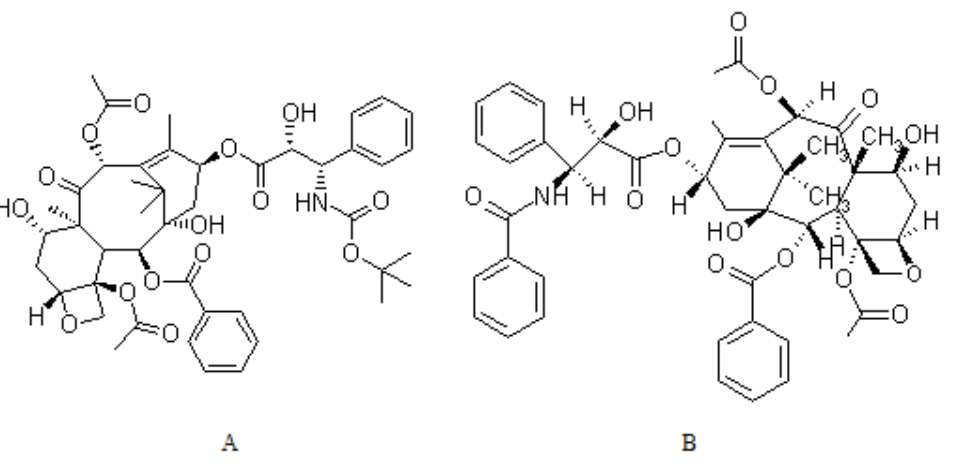
Figure 1. Structure of Docetaxel (DTX) ( A ) and Paclitaxel ( B